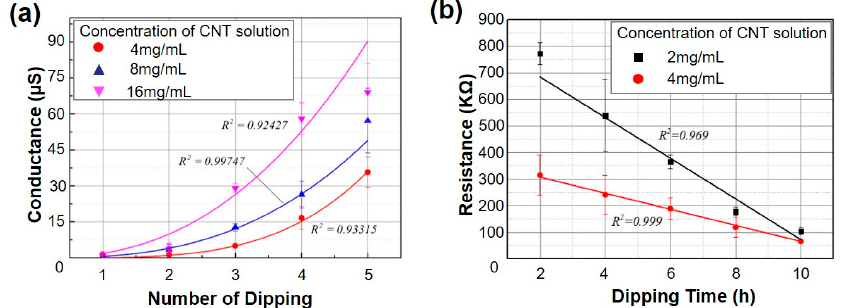
Figure 4. ( a ) The relationship between the conductance of SWNT-CY and the total number of dips of the cotton yarn into the SWNT solution at concentrations of 4 mg/mL, 8 mg/mL, and 16 mg/mL (error bars show the standard deviations of five examples); ( b ) The relationship between the resistance of SWNT-CY and dipping time in the SWNT solution at concentrations of 2 mg/mL and 4 mg/mL (error bars show the standard deviations of five examples).